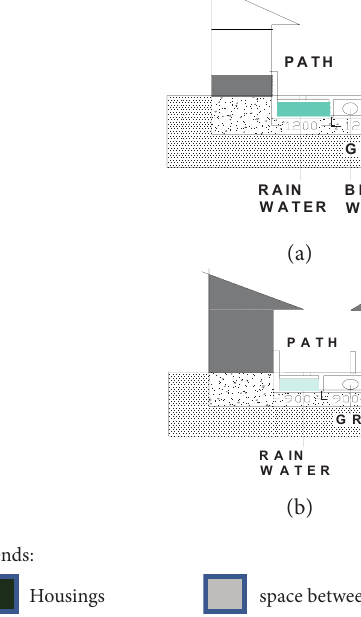
Figure 6. (a) Secondary and (b) Tertiary Drainage systems; (c) The pattern of drainage flow in Kampong